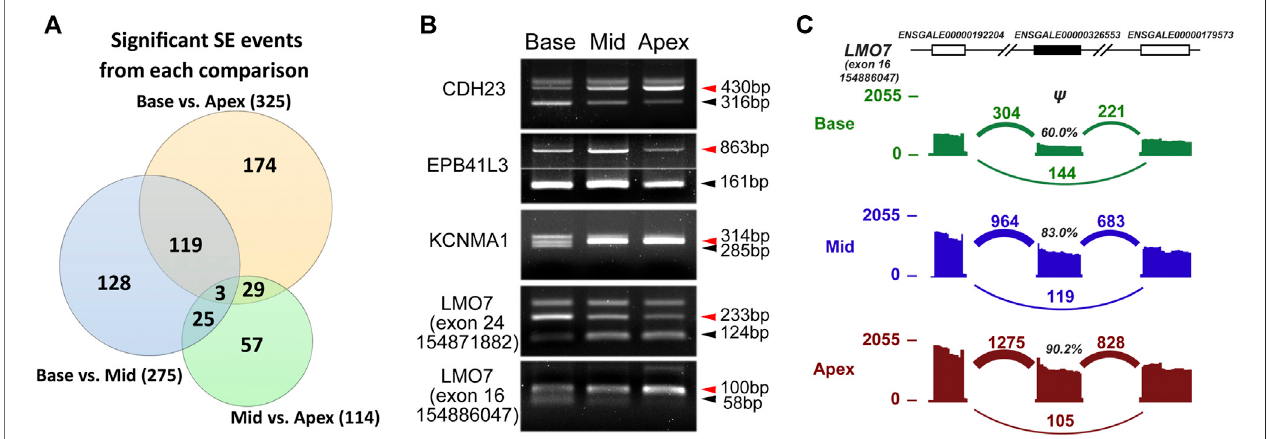
FIGURE3| Comparison ofASpro fi les alongthe tonotopic axis. (A) Number ofsigni fi cantskipped exon(SE) eventsfrom each comparison at FDR < 5%and | Δψ | ≥ 5%. (B) RT-PCR – based exon inclusion levels of fi ve tonotopic signature exons. (C) A skipped exon event of the LMO7 gene reported by rMATS (the last event in B) is shownwithits fl ankingexons.Histogramsrepresentexonreaddensityandarcsrepresentsplicejunctionswiththenumberofreadsmappedtothejunctionindicatedby the thickness of the arc. Both splice junction counts and exon read counts indicate that the target exon (solid) usage increases along the tonotopic